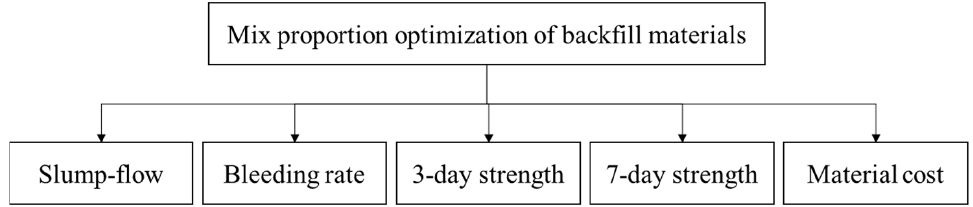
Figure 2. Hierarchy of mix-proportion optimization.